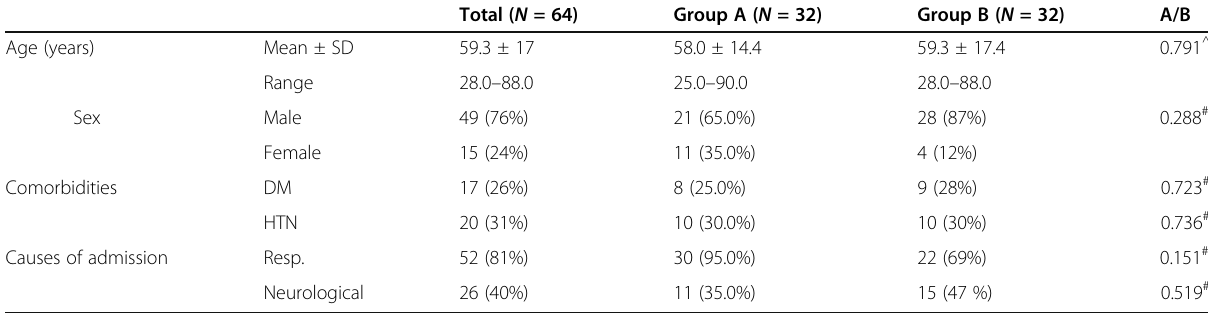
Table 2 Comparison between study groups as regards age, sex, and causes of ICU